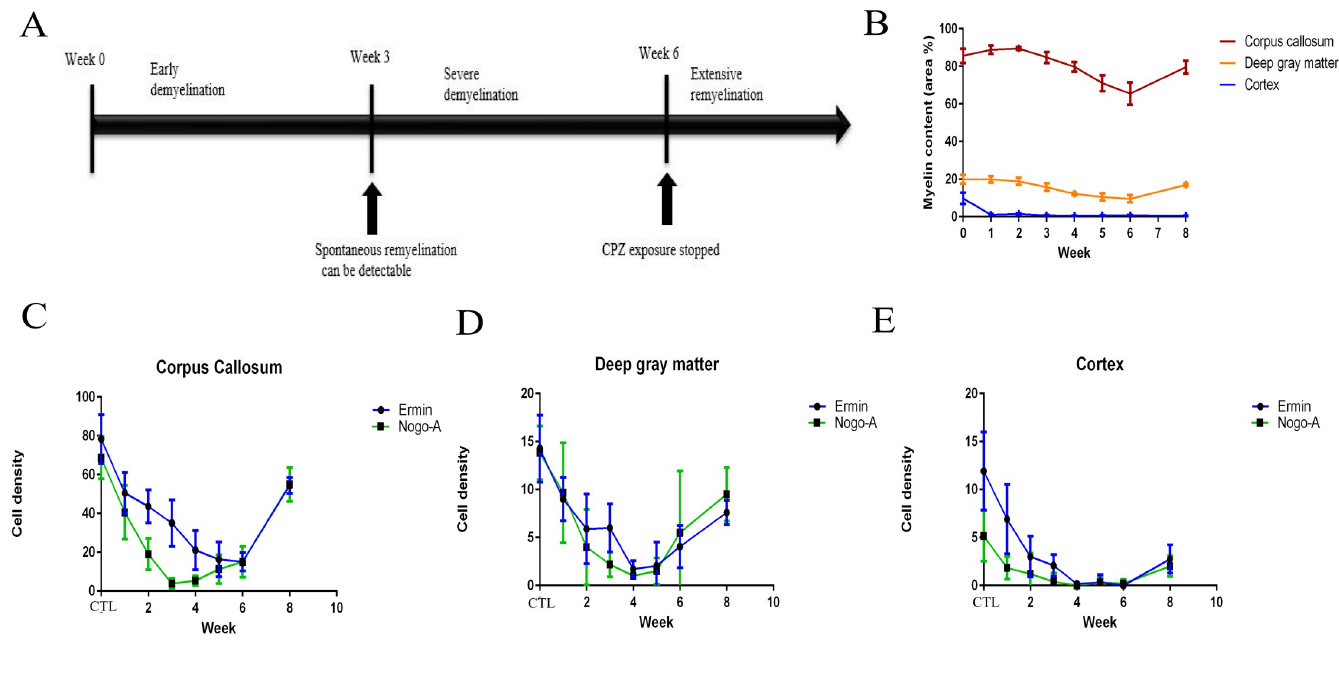
Fig 2. Temporal dynamics of ermin and Nogo-A immunopositive cell density and myelin content over the course of de- and remyelination in the cuprizone mouse model. (A) Schematic diagram of the course of demyelination/remyelination in the cuprizone mouse model (B) Temporal change of myelin content, measured by immunohistochemistry for proteolipid protein (PLP) (mean, SEM). (C-E) Temporal change of ermin and Nogo-A- immunopositive cell density (mean, SEM) in the corpus callosum (C), deep gray matter (D), cortex (E) from week 1 to week 8. CTL: Controls. Cuprizone exposure led to progressive demyelination and oligodendrocyte loss. The density of Nogo-A+ cells fell more rapidly than the density of ermin+ cells during the first 3 weeks (C-E). Two weeks after cuprizone exposure was stopped (week 8) remyelination was evident in corpus callosum and deep gray matter, but not in cerebral cortex (B).